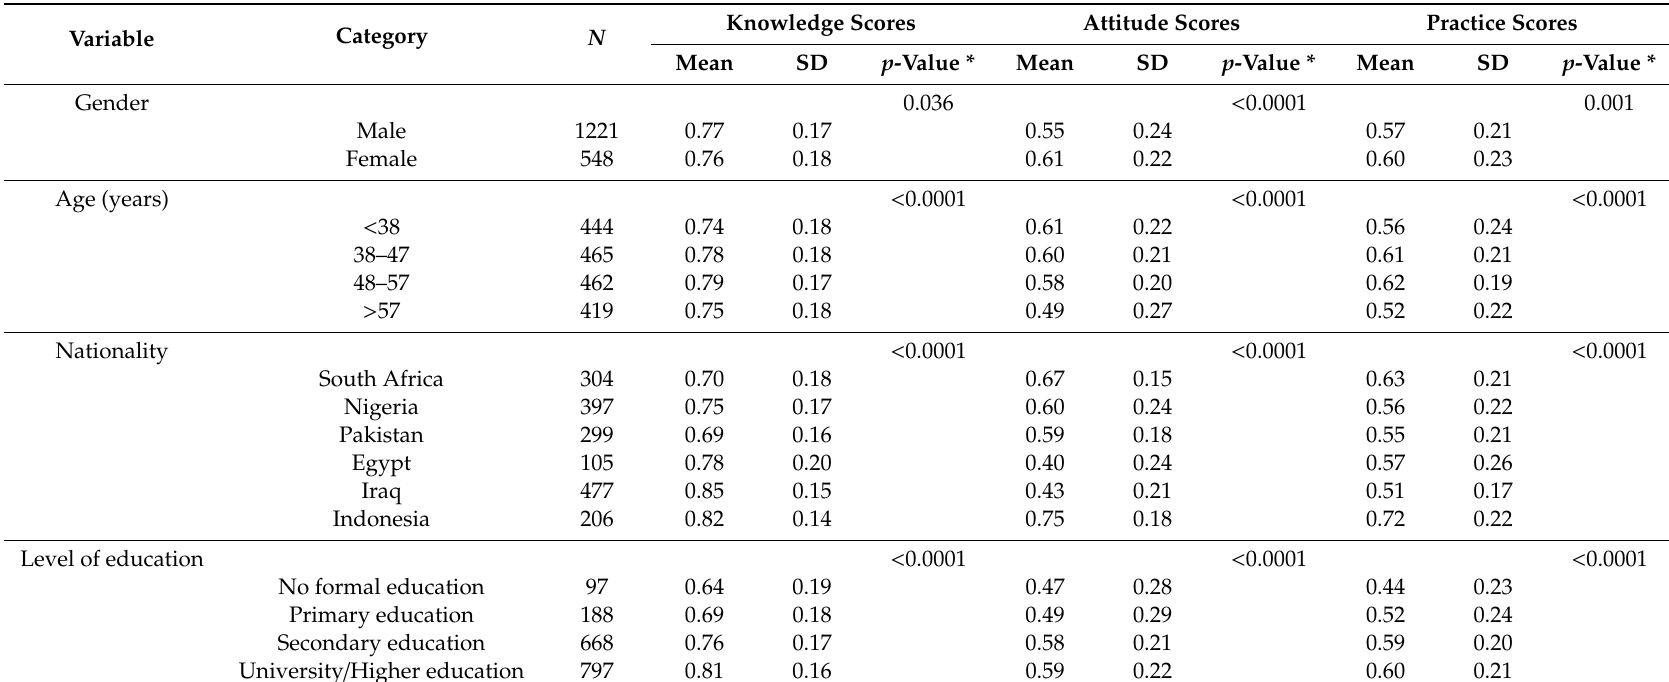
Table 3. Demographic variables and knowledge, attitude and practice